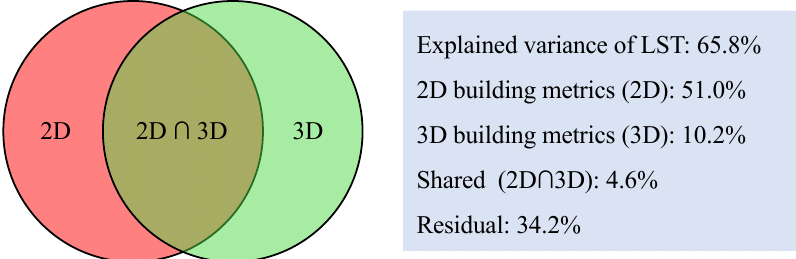
Figure 4. Venn diagram showing the results of variance partitioning and percentages of explained variances of LST by 2D/3D building metrics.